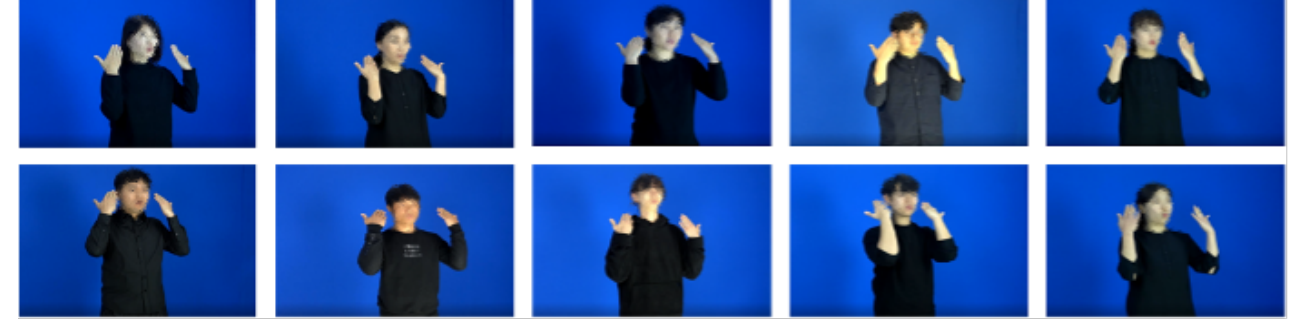
Figure 11. Examples of sign language datasets representing "school" word performed by 10 signers in the side angle.